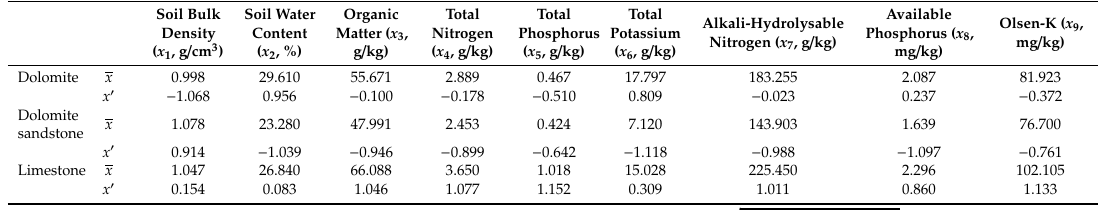
Table 2. Characteristics of the three lithological soil types.